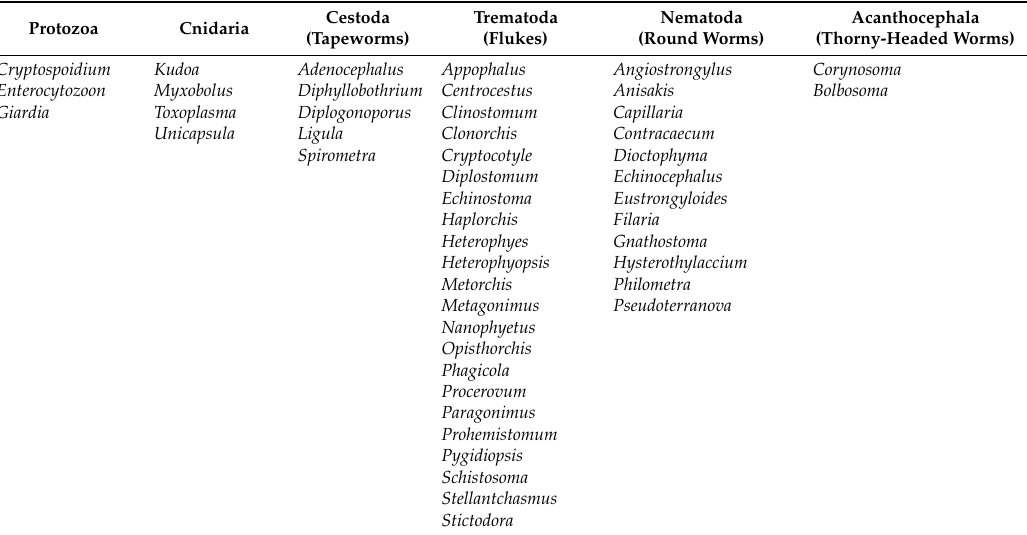
Table 1. List of the genera of seafood-borne parasites reported from